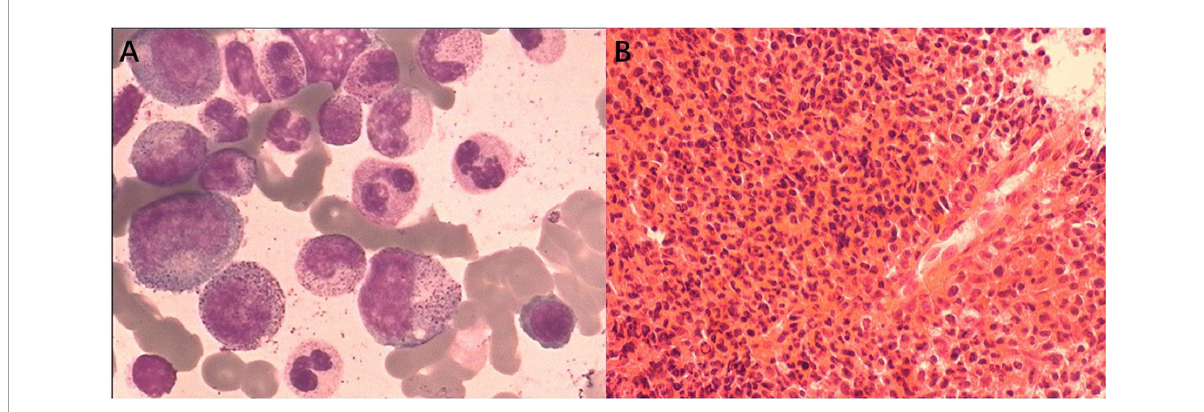
FIGURE2 Bone marrow studies revealed hypercellular marrow with granulocytic hyperplasia. (A) Bone marrow smear (Wright’s stain; original magnification, × 400). (B) Bone marrow biospy (Hematoxylin-eosin stain; original magnification, ×